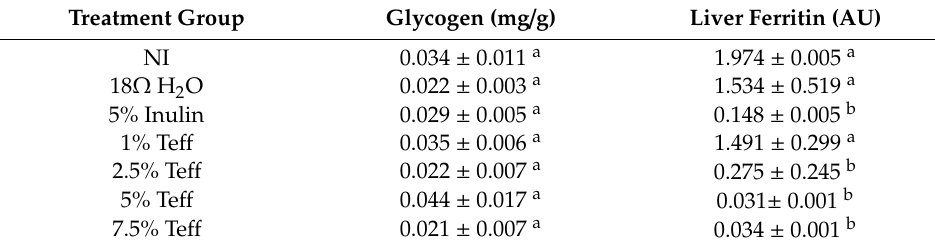
Table 7. Glycogen and liver ferritin concentrations 1 .